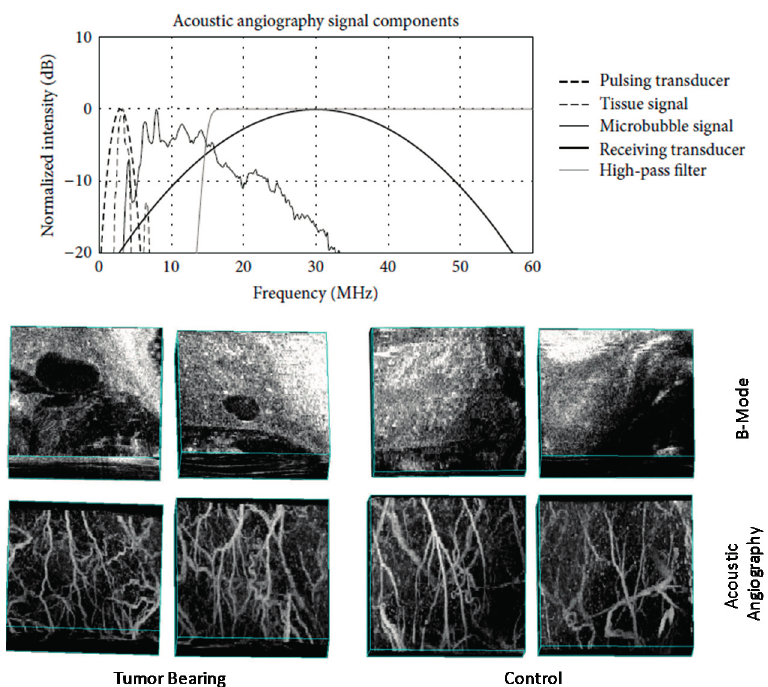
Figure 3. Acoustic angiography amplitude spectrum ( top ) and example images ( bottom ). Wideband separation between tissue response and microbubble response produces images that are drastically different from conventional B-mode images and illustrate blood flow in the microvasculature with high-resolution and high-contrast to tissue ratio. Acoustic angiography images displayed using maximum intensity projections of volumetric scan volumes. Bounding boxes are approximately 0.75 × 1.25 × 1.5 cm (axial, lateral, and elevational). Figure adapted from [68].